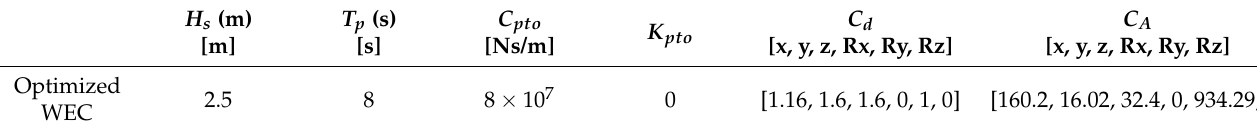
Table 1. Damping and drag forces used in this study for one example wave condition. The damping coefficients [ C d , C A ] are calculated based on typical shapes, and the damping coefficients [ C pto ] are optimized for optimal power performance for each wave period. The spring constant is represented by K pto . Rx, Ry and Rz refer to the rotation in x, y and z directions, also known as roll, pitch and yaw.